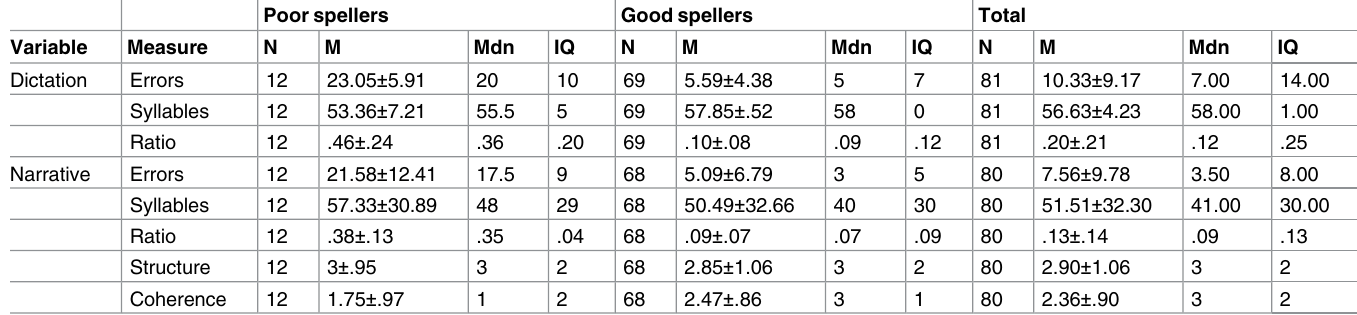
Table 2. Standardized test descriptive statistics: number of participants, mean, standard deviation, median and interquartile